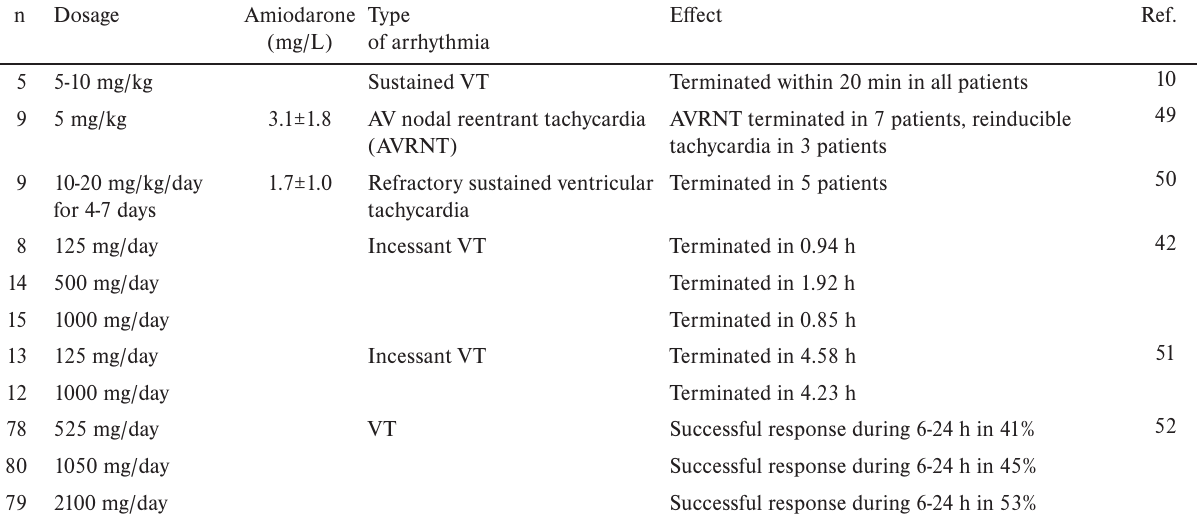
Table 2. Intravenous administration of amiodarone (DEA levels were not measured.